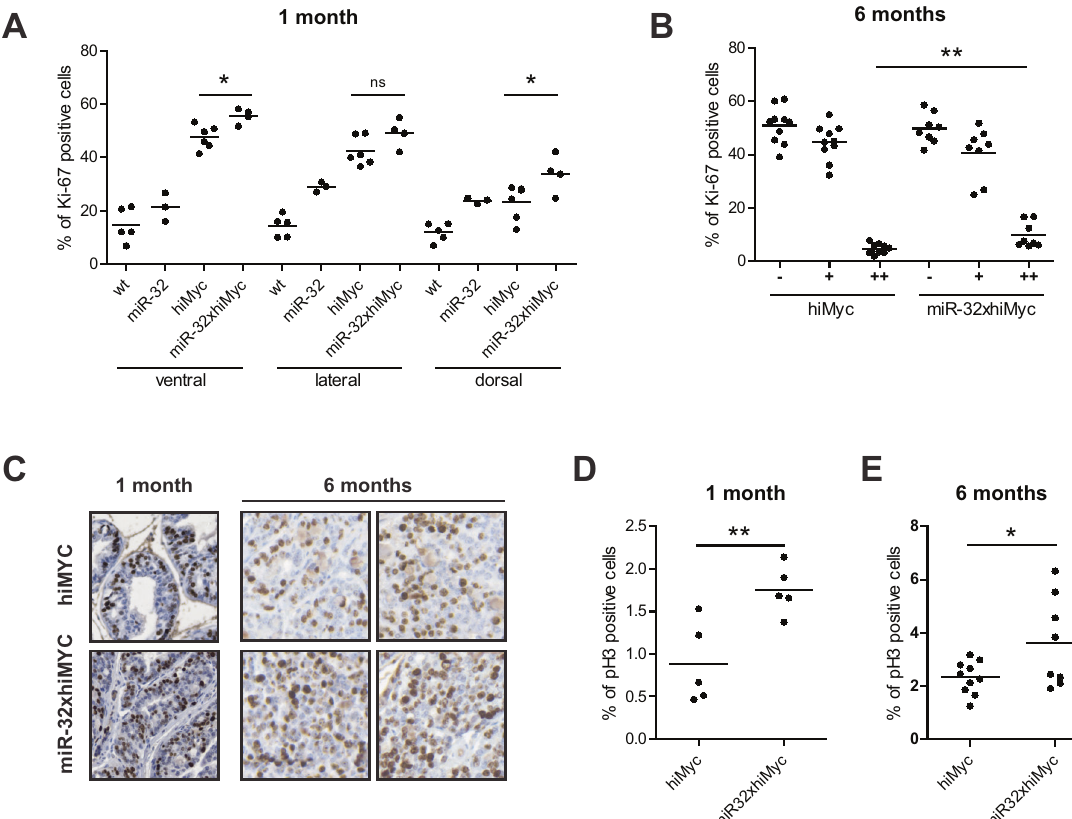
Fig. 2 Proliferation is induced by transgenic miR-32 in prostate epithelium and tumors in hiMYC mice. A Percentage of prostate epithelial nuclei positive for proliferation marker Ki-67 immunostaining in ventral, lateral, and dorsal lobes of wt, miR-32 transgenic, hiMYC, and miR- 32xhiMYC mice at 1 month of age. B Percentage of nuclei positive for Ki-67 immunostaining in hiMYC and miR-32xhiMYC mice tumors at 6 months of age. – no staining, + weak to intermediate staining, ++ strong staining. C Example images of Ki-67 immunostaining in hiMYC and miR-32xhiMYC mouse prostate epithelium at 1 month and tumors at 6 months of age. D Percentage of prostate epithelial cells positive for mitotic marker pH3 immunostaining in hiMYC and miR-32xhiMYC mice at 1 month of age. E Percentage of cells positive for pH3 immunostaining in hiMYC and miR-32xhiMYC mice tumors at 6 months of age. p values *<0.05,